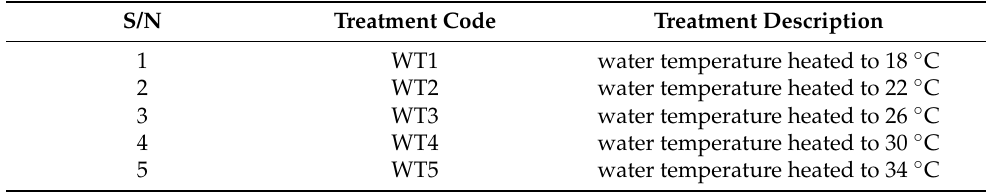
Figure 3. A completely randomized experimental block design used for the investigation (Diagram: J.D. Viljoen). Table 1. Water temperature treatments and temperature ranges.